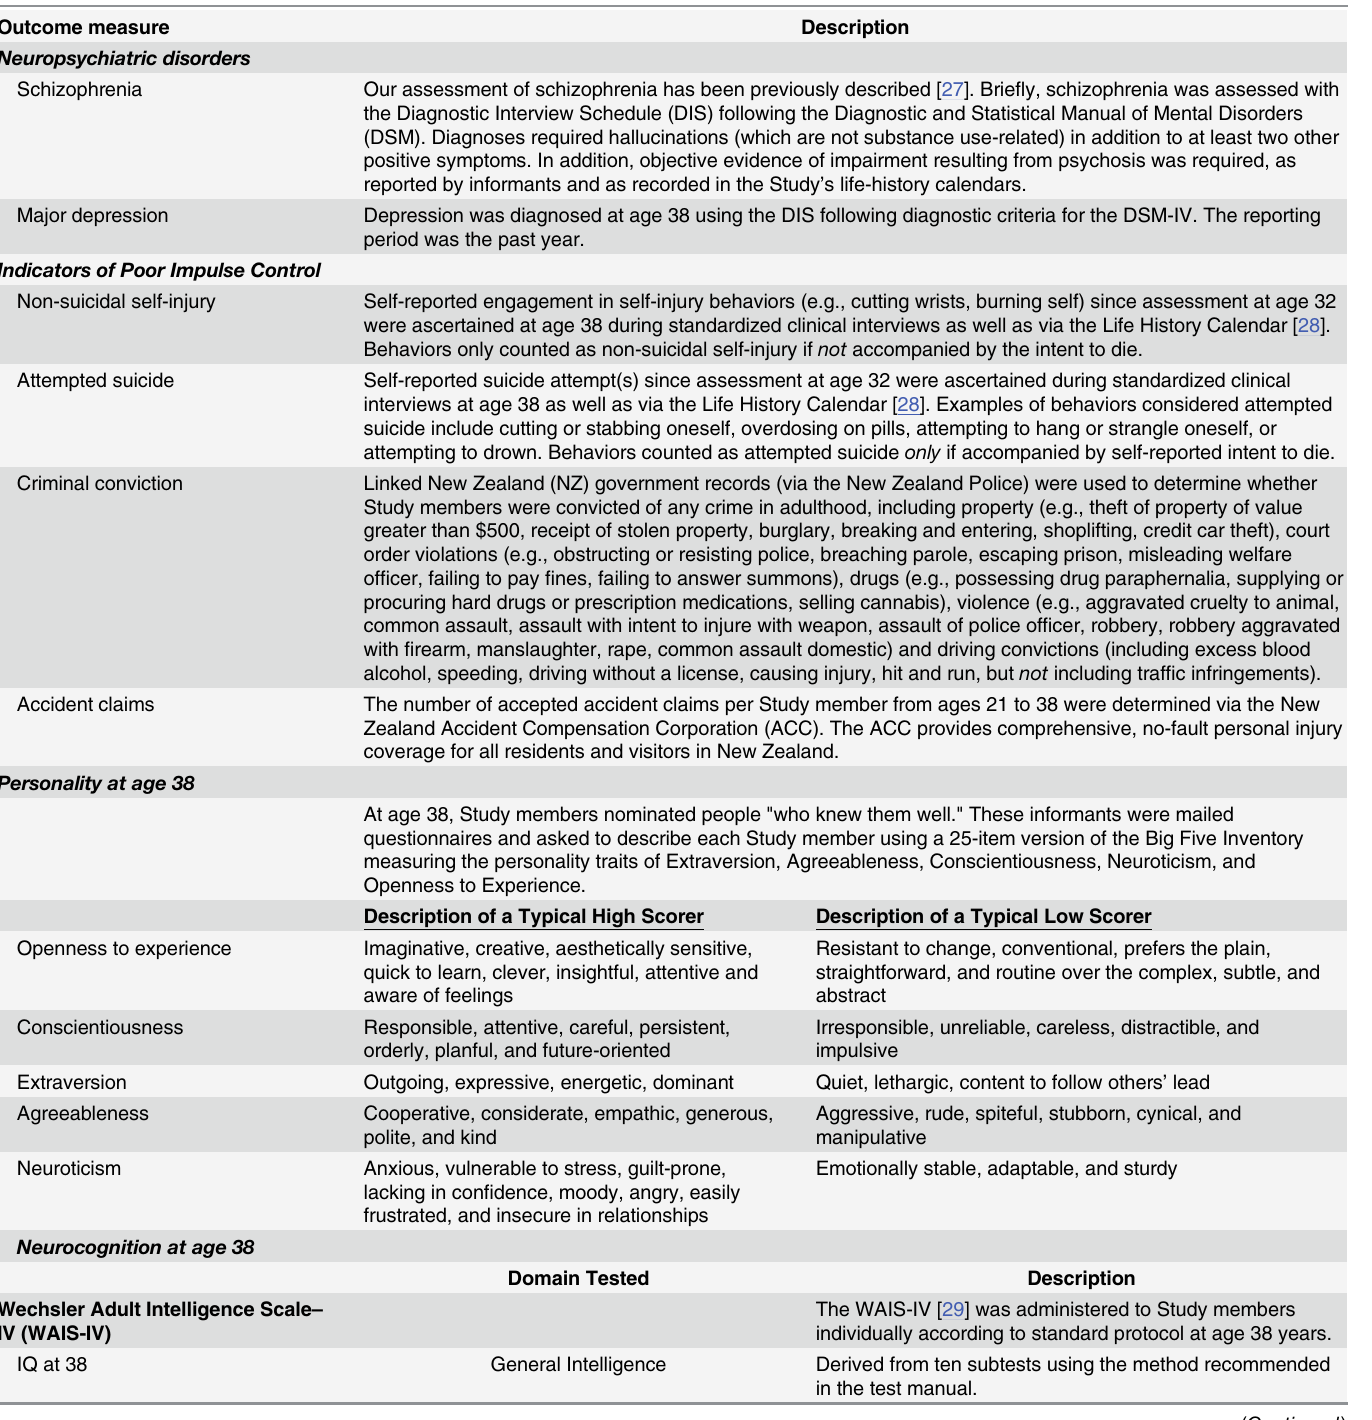
Table 1. Brief description of neuropsychiatric, impulse control, personality and neurocognitive outcome measures used in the